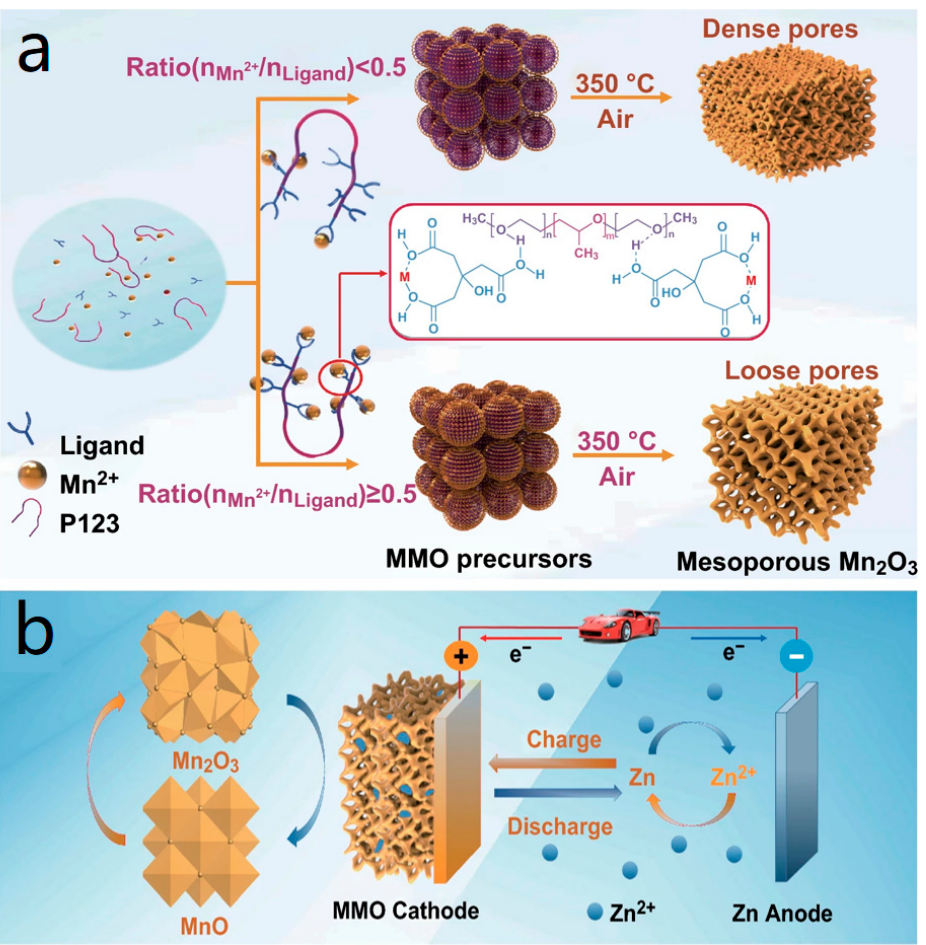
Figure 1. ( a ) Schematic illustration of the preparation process of Mn 2 O 3 Mesoporous structured cath- odes. ( b ) Schematic Illustration of charge/discharge process of Zn||Mn 2 O 3 aqueous rechargeable battery. Reproduced with permission from reference [27].